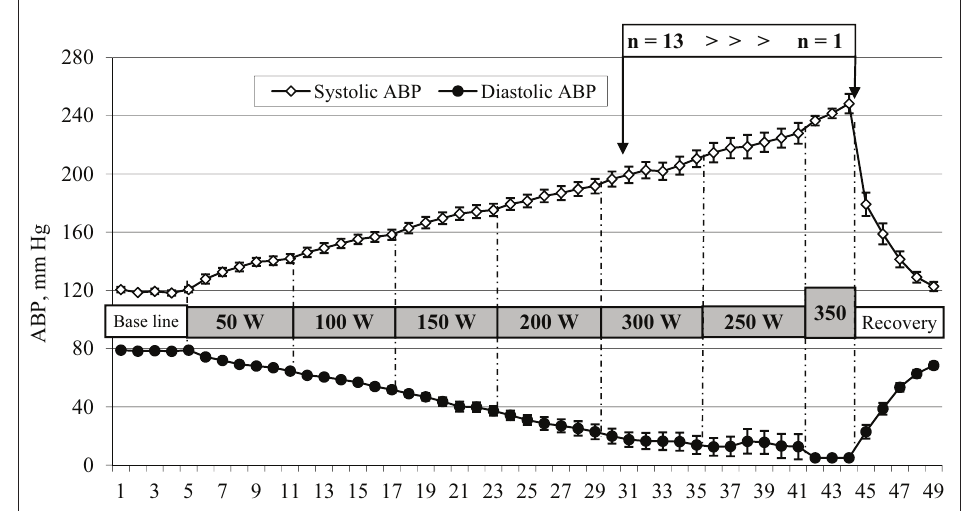
Figure 1. Cardiac output (CO) changes during incremental exercise stress